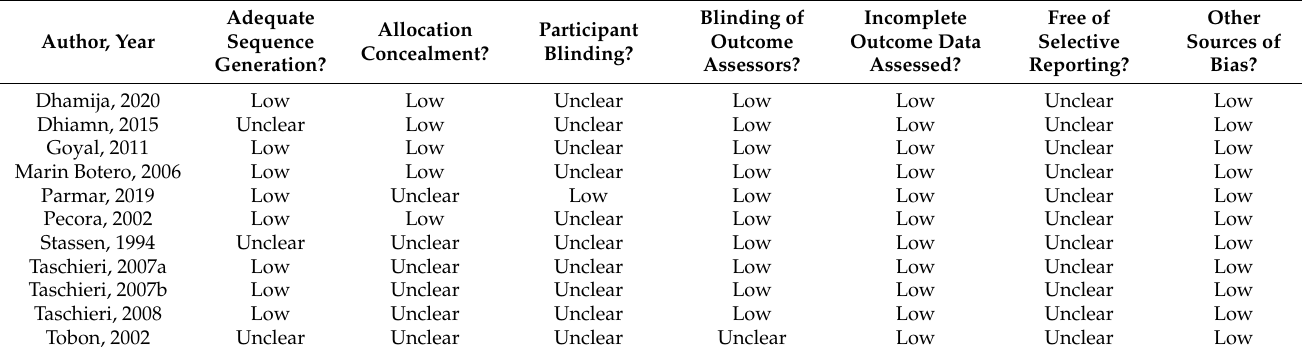
Table 1. Cochrane Collaboration tool for assessing risk of